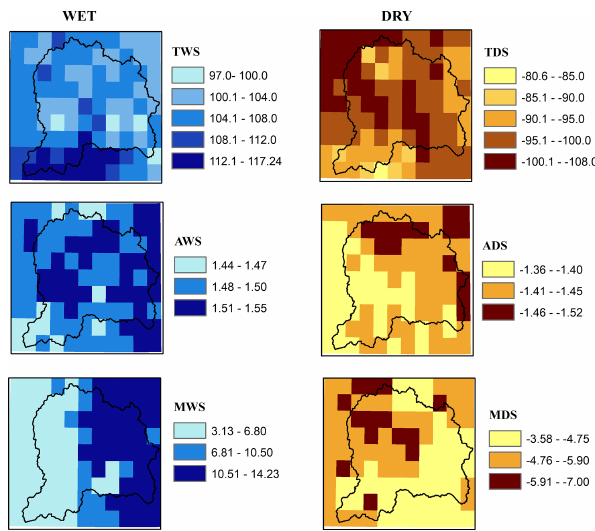
Figure 5. Spatial distribution of total wet severity (TWS), total dry severity (TDS), average wet severity (AWS), average dry severity (ADS), maximum wet severity (MWS), and maximum dry severity (MDS) for the period 1981–2014.